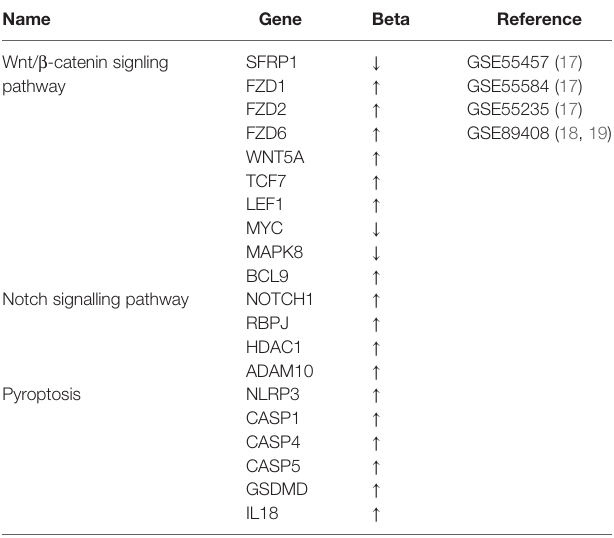
TABLE 1 | Differentially expressed genes involved in Wnt/ b -catenin, Notch signaling pathway and pyroptosis in RA-FLS (P<0.05) .